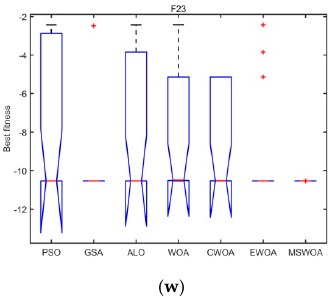
Figure 3. Box and whisker test for the seven algorithms on F1 to F23. ( a ) Box and whisker test on F1;